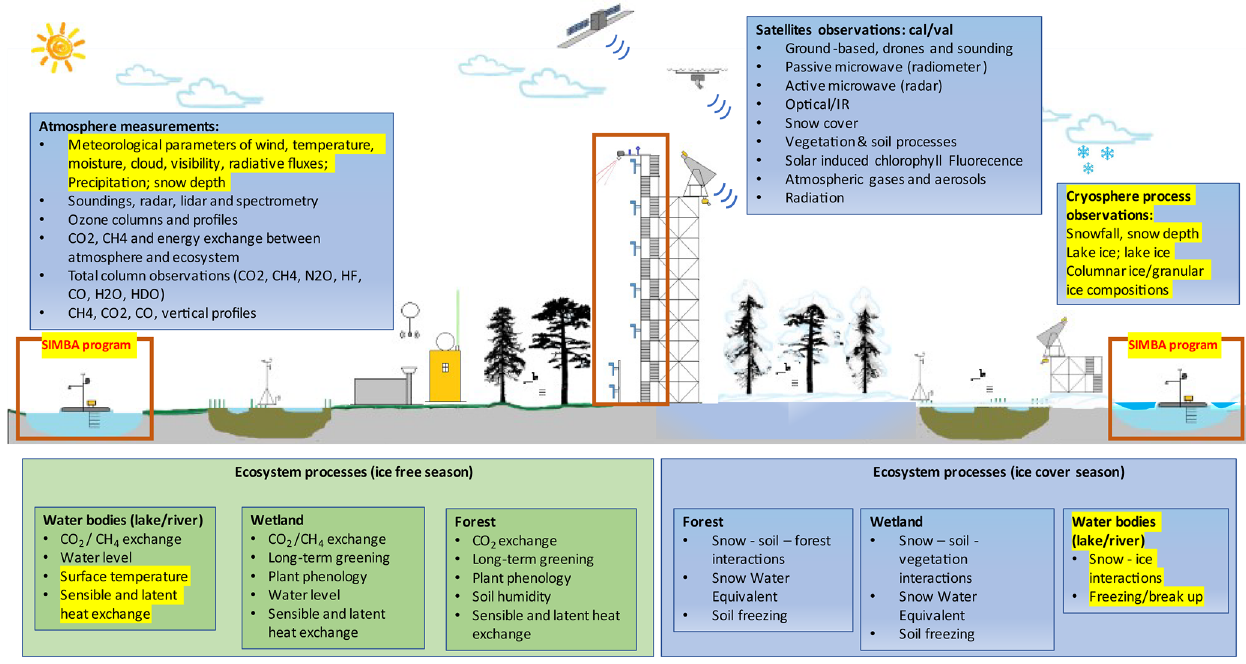
Figure 1. Schematic diagram of the FMI-ARC supersite observational systems at Sodankylä. The original diagram is at https://litdb.fmi.fi/ (last access: 10 August 2021). The frames in red and text with yellow background describe the measurements addressed in this paper.